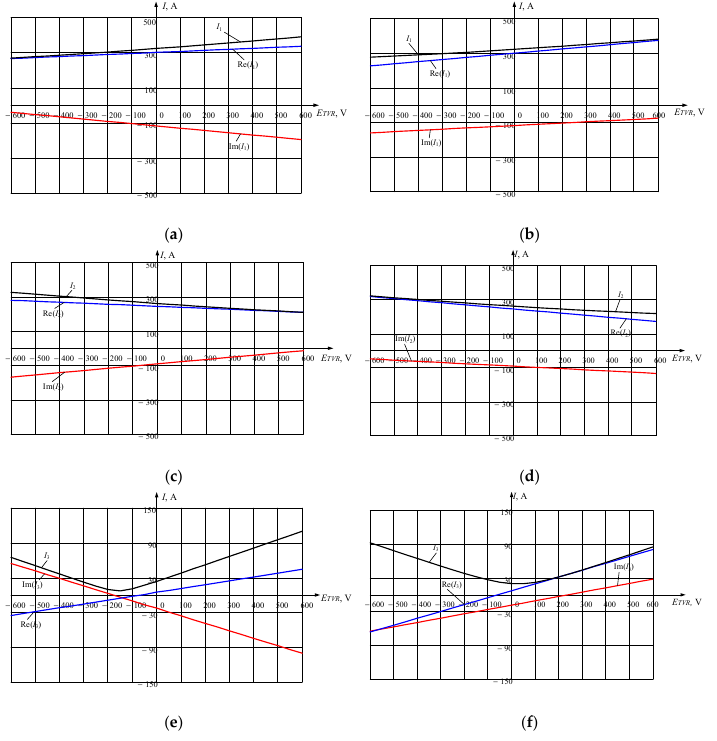
Figure 11. Dependences of the real, reactive, and complex components of the currents on the TVR additional voltage: ( a ) I 1 under voltage magnitude control mode, ( b ) I 1 under phase angle control mode, ( c ) I 2 under voltage magnitude control mode, ( d ) I 2 under phase angle control mode, ( e ) I 3 under voltage magnitude control mode, and ( f ) I 3 under phase angle control mode. The step of the additional voltage of the voltage magnitude and phase angle control modules is ±600 V. It provides a range of voltage magnitude controls of ±10.4% and phase angle controls of ±5.9°. It can be seen from the dependencies (Figure 11) that the control of the real and reactive components of the currents occurs both under voltage magnitude and phase angle control modes. The largest range of current regulation is observed under the combined control mode. Figure 12 shows the dependences of RMS currents I 1 , I 2, and I 3 with different regulating methods of the TVR output voltage. The presented graphs allow the determination of the current of the considered DN parts under the voltage magnitude, phase angle, and combined control modes.